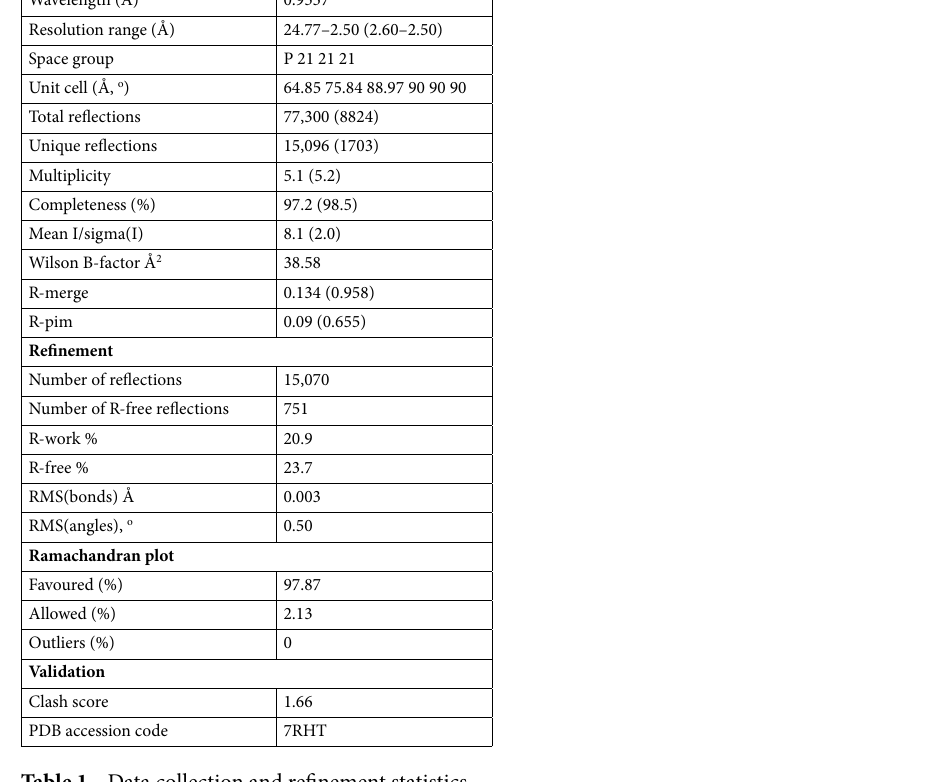
Table 1. Data collection and refinement